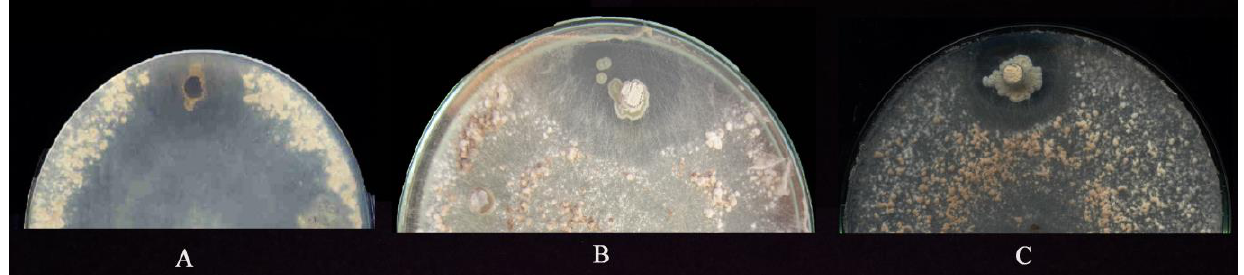
Figure 1. Inhibition zone of Actinomycetes isolates against Rhizoctonia solani : ( A ) isolate U, ( B ) isolate G, and ( C ) isolate No. 5.